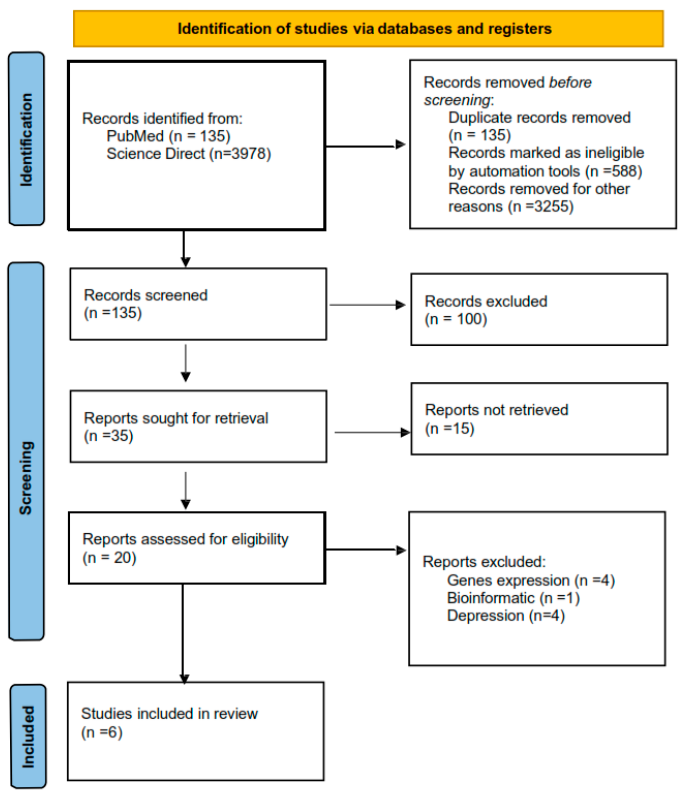
Figure 1. PRISMA fl ow chart that includes all the processes of choosing